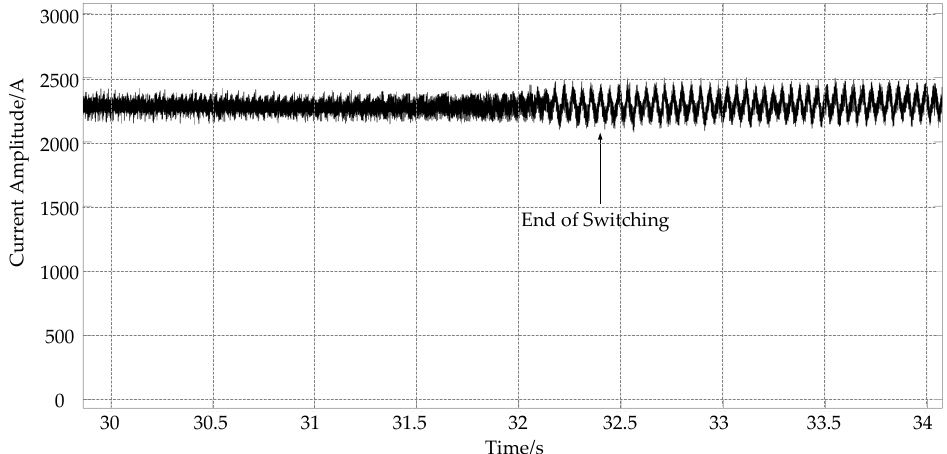
Figure 21. The q -axis current on the stator where the train is entering. The thrust of the train during the switching process is shown in Figure 22. It can be seen that during the switching process, since the stator current does not drop, the thrust does not drop either. Therefore, with other traction and power supply methods being the same, the acceleration of the train is greater during the whole driving process, making the train run faster and more stable when applying the three-step method.